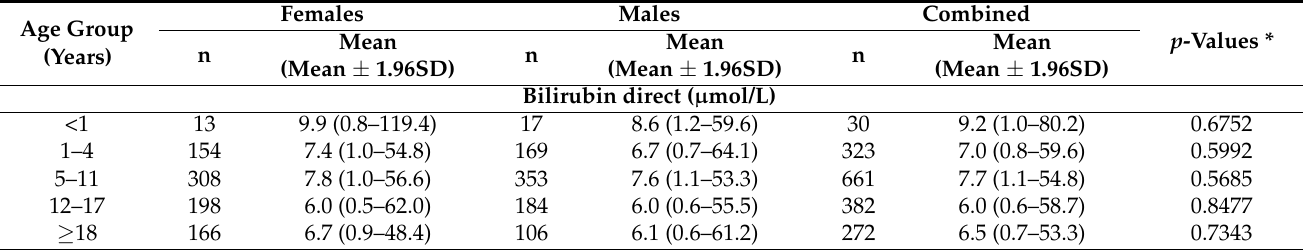
Table 3. Steady state biochemical reference values calculated as mean (mean ± 1.96SD) in SCD, categorized by age groups and